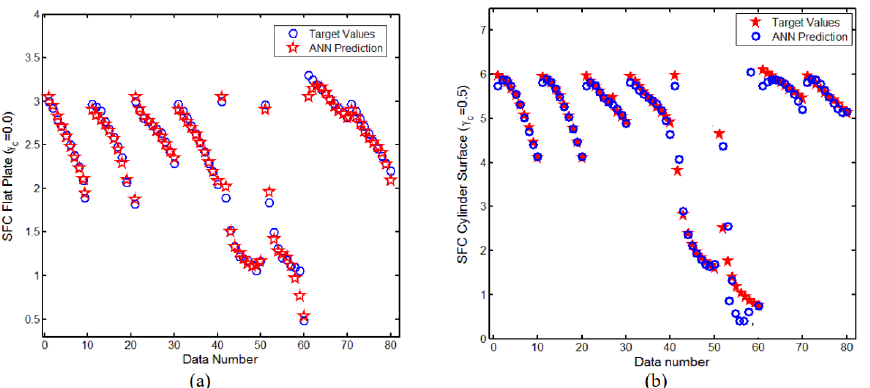
Figure 7. ( a ) Estimation of ANN and target data set for flat surface; ( b ) Estimation of ANN and target data set for cylindrical surface.